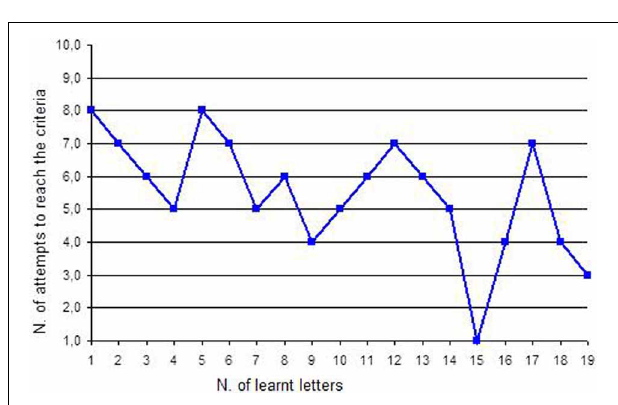
FIGURE 3 | Number of attempts to reach the criteria for each letter.